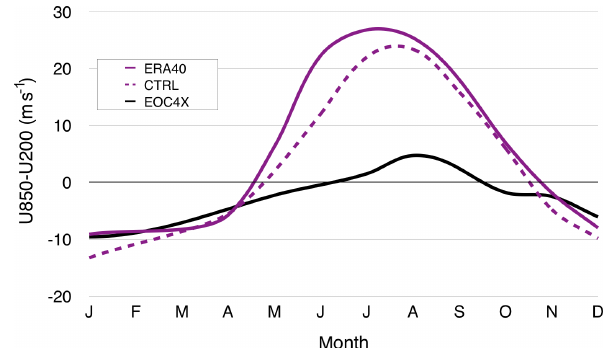
Figure 9. Application of the Webster and Yang Index (on the re- gion 40–110 ◦ E, 0–20 ◦ N) and comparison of the results obtained for EOC4X (black), control simulation (dotted) and reanalysis (pur-